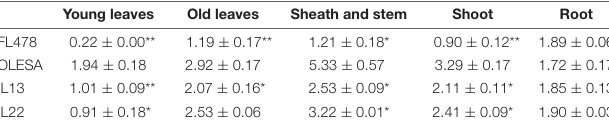
TABLE 1 | Na + /K + molar ratios in different tissues of introgression rice lines and parents. Young